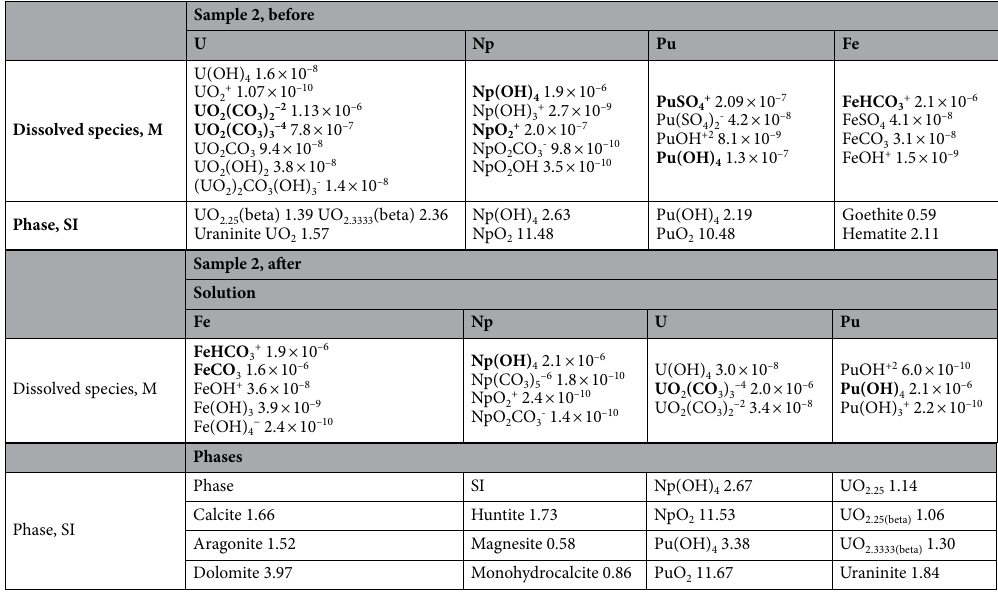
Table 5. The major species of actinides and iron in the liquid (M) and solid phases (Si saturation indexes) in the aquifer, after microbial treatment. Significant values are in